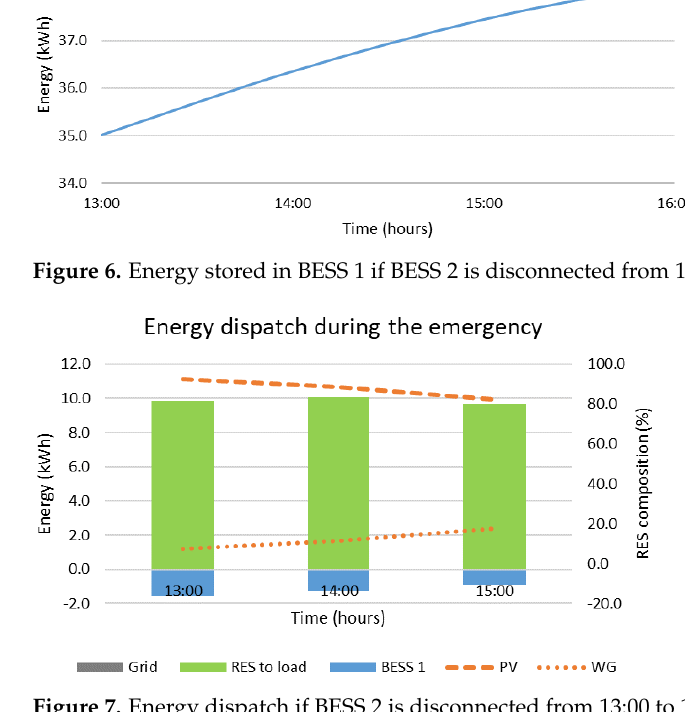
Figure 7. Energy dispatch if BESS 2 is disconnected from 13:00 to Figure 7 . Energy dispatch if BESS 2 is disconnected from 13:00 to 16:00.